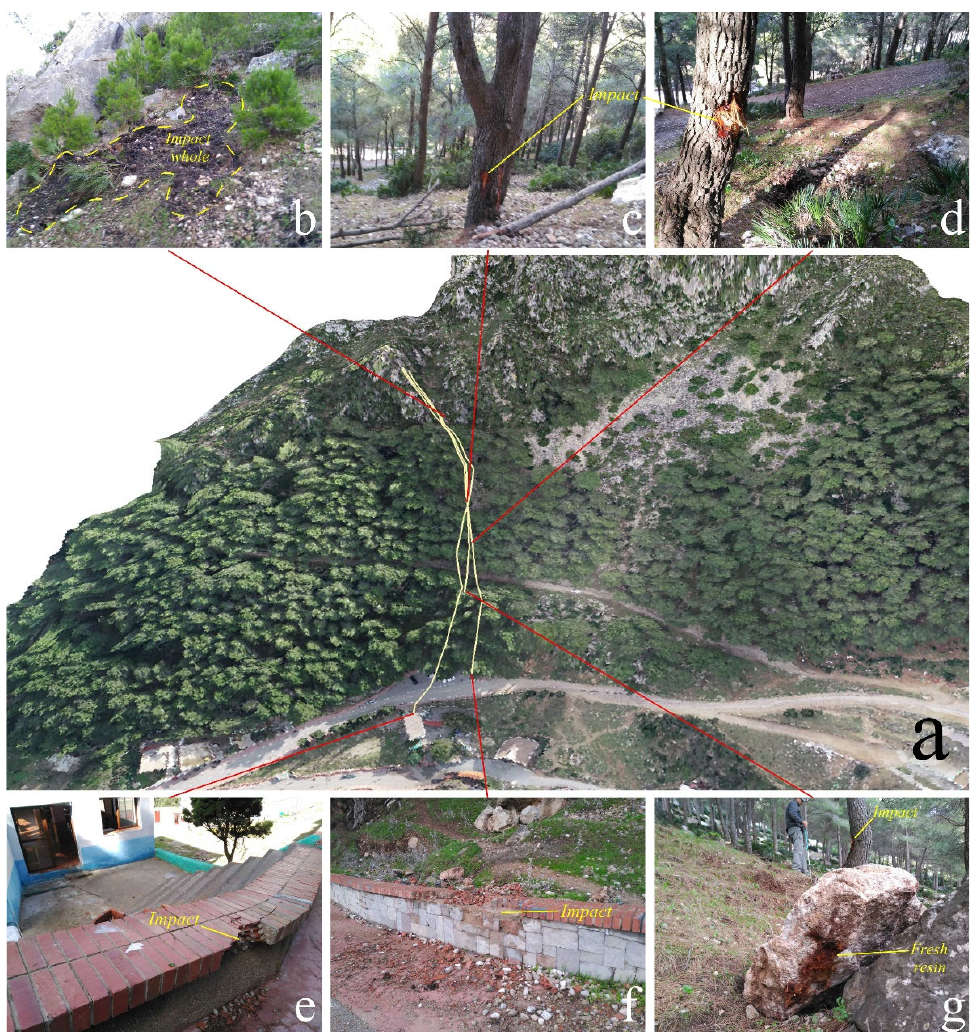
Figure 6. ( a ) Trajectories of the 2018 event projected over the UAV ‐ derived orthoimage. ( b ) Boulder impact near the source area. ( c ) and ( d ) Mechanical injuries on the tree stems. ( e ) and ( f ) impact observed on manmade structures. ( g ) photograph showing a recently detached boulder with fresh resin and live wood stains on its surface and its supposed impact on a nearby tree.